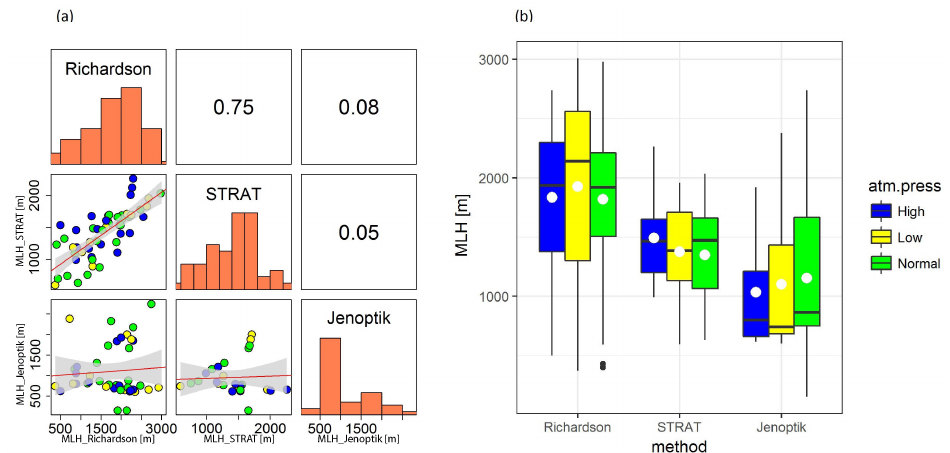
Figure 3. A correlation matrix ( a ) and Tukey’s box and whiskers plot ( b ) of radiosonde-(Richardson) and LiDAR-based (STRAT and Jenoptik) algorithms for MLH detection. Conventions are the same as in Figure